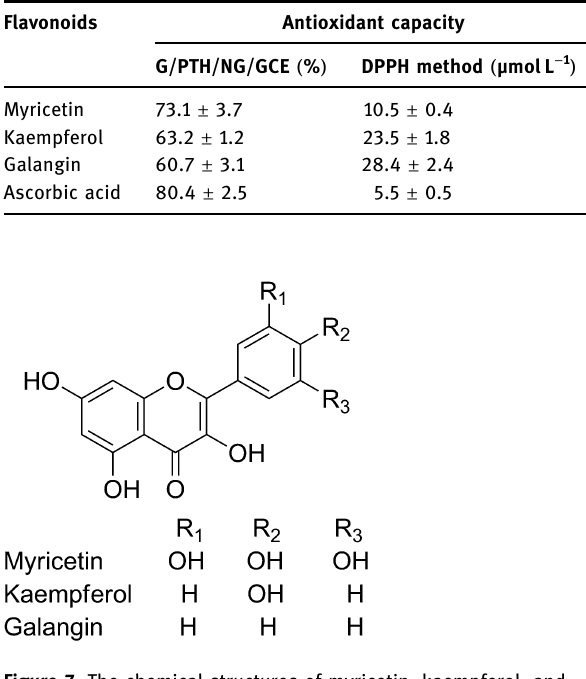
Figure 7: The chemical structures of myricetin, kaempferol, and galangin.